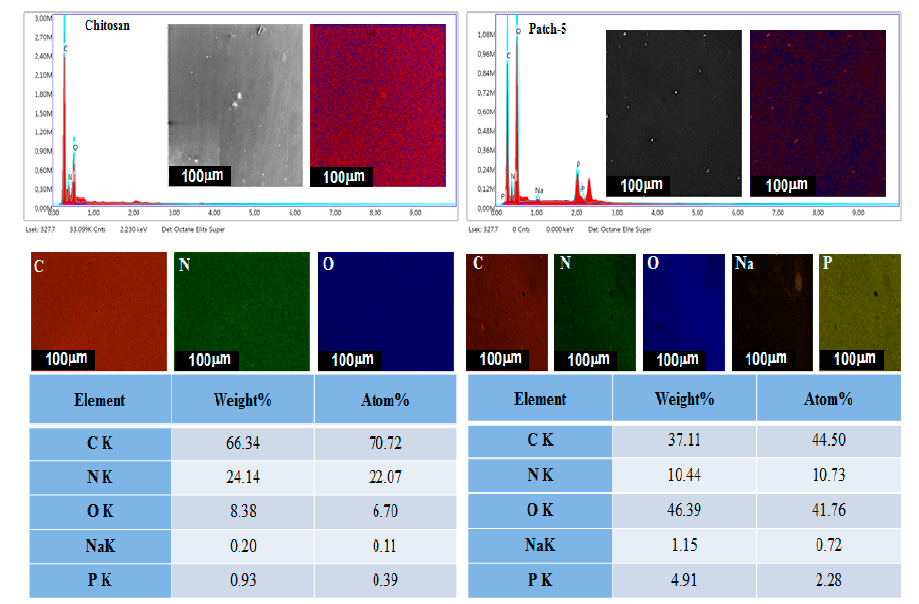
Figure 3. EDX and elemental mapping of pristine chitosan and patch - 5.